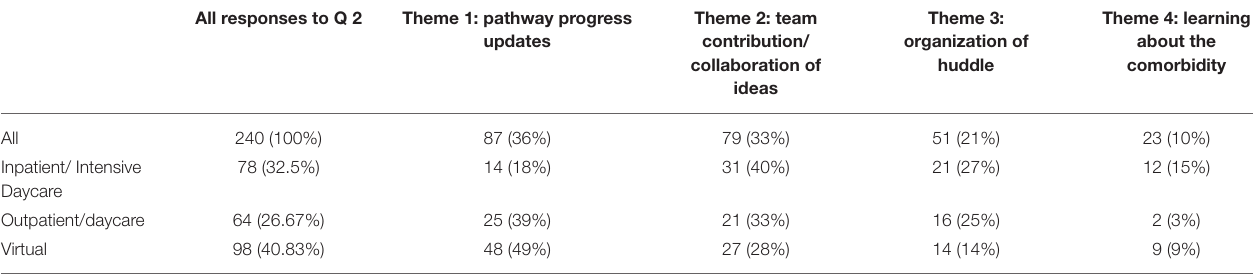
TABLE 2 | A table showing % themes identified from responses across the huddles to question 2 “what went well in the huddle.” All responses to Q 2